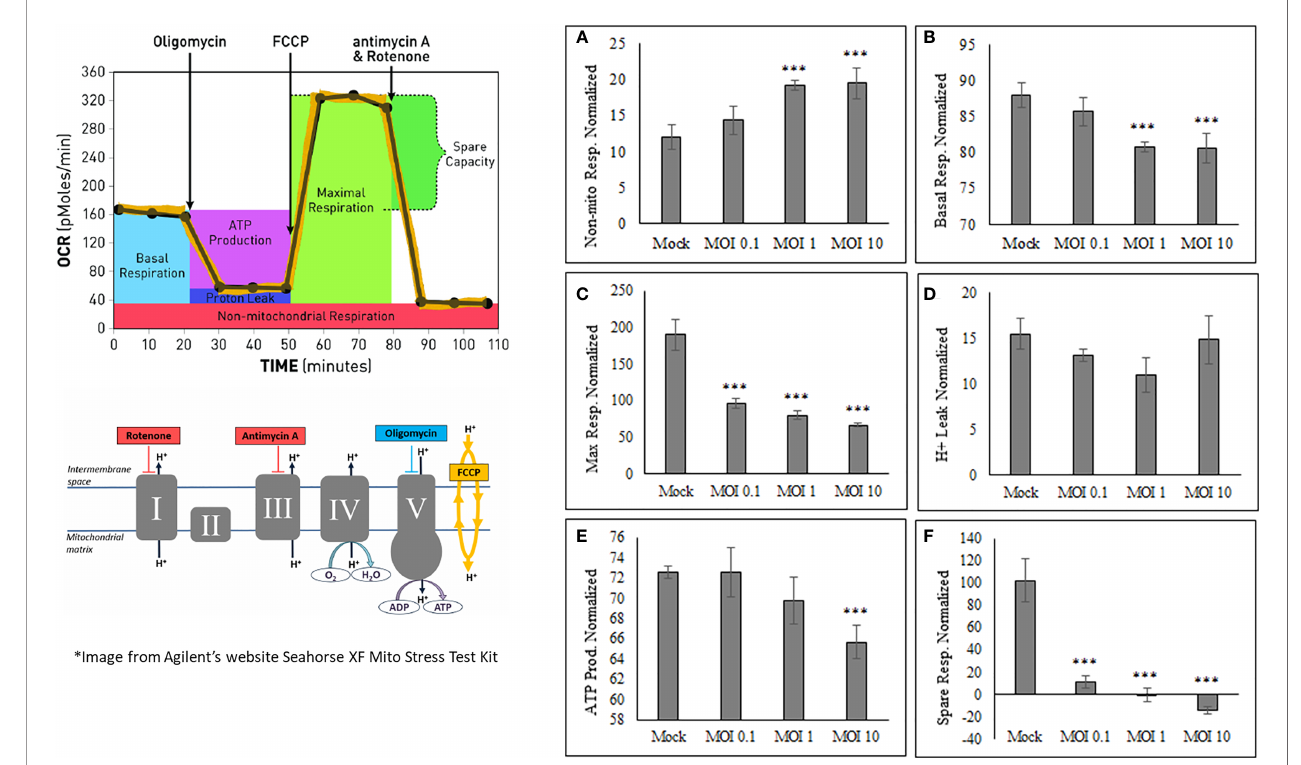
FIGURE 3 | SINV causes decrease in ATP production and increase in non-mitochondrial respiration. The Seahorse data obtained shows an increase in only nonmitochondrial respiration (A) , with a decrease in basal respiration (B) , maximum respiration (C) , ATP production (E) and spare respiratory capacity (F) . No change was seen in proton leak (D) . These values are calculated from various time points within the OCR and ECAR readings using HEK cells. (***) indicates a p- value of less than